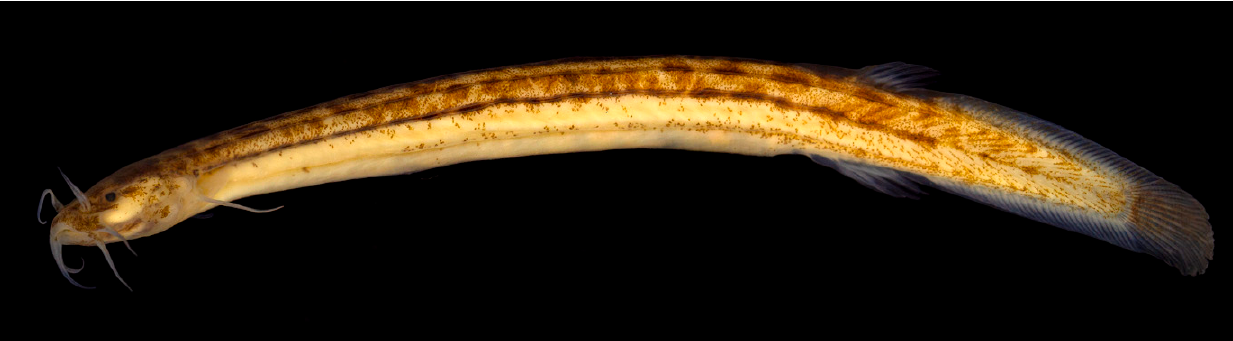
Figure 7. Listrura macaensis sp. nov., UFRJ 12667, holotype, 42.7 mm SL. Holotype. UFRJ 12667, 42.7 mm SL; Brazil: Estado do Rio de Janeiro: Município de Rio das Ostras: small stream inside União Biological Reserve, Rio Macaé basin, 22°26 ′ 10 ″ S 42°03 ′ 04 ″ W, about 20 m asl; LASEPT team, 9 November 2012. Paratypes. UFRJ 9065, 1, 25.5 mm SL; UFRJ 9996, 1 (C&S), 26.5 mm SL; CICCAA 04081, 1, 31.7 mm SL; same collecting data as holotype. – UFRJ 9693, 1 (DNA), 32.5 mm SL; UFRJ 9758, 2 (C&S), 27.3–29.2 mm SL; same locality as holotype; A. M. Katz, M. A. Barbosa and F. R. Pereira, 6 September 2013.